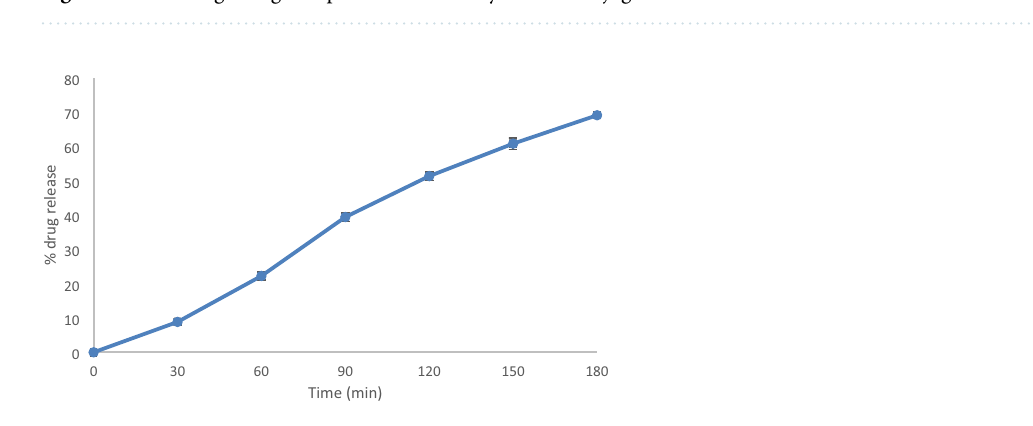
Figure 9. Percentage drug encapsulation efficiency of nanoconjugate.